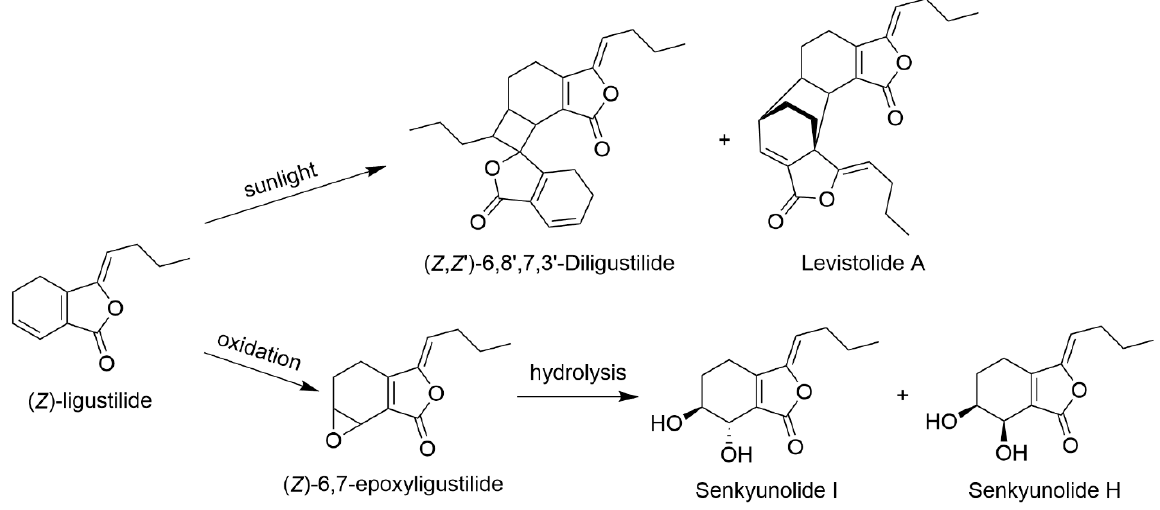
Figure 3. Chemical transformation of